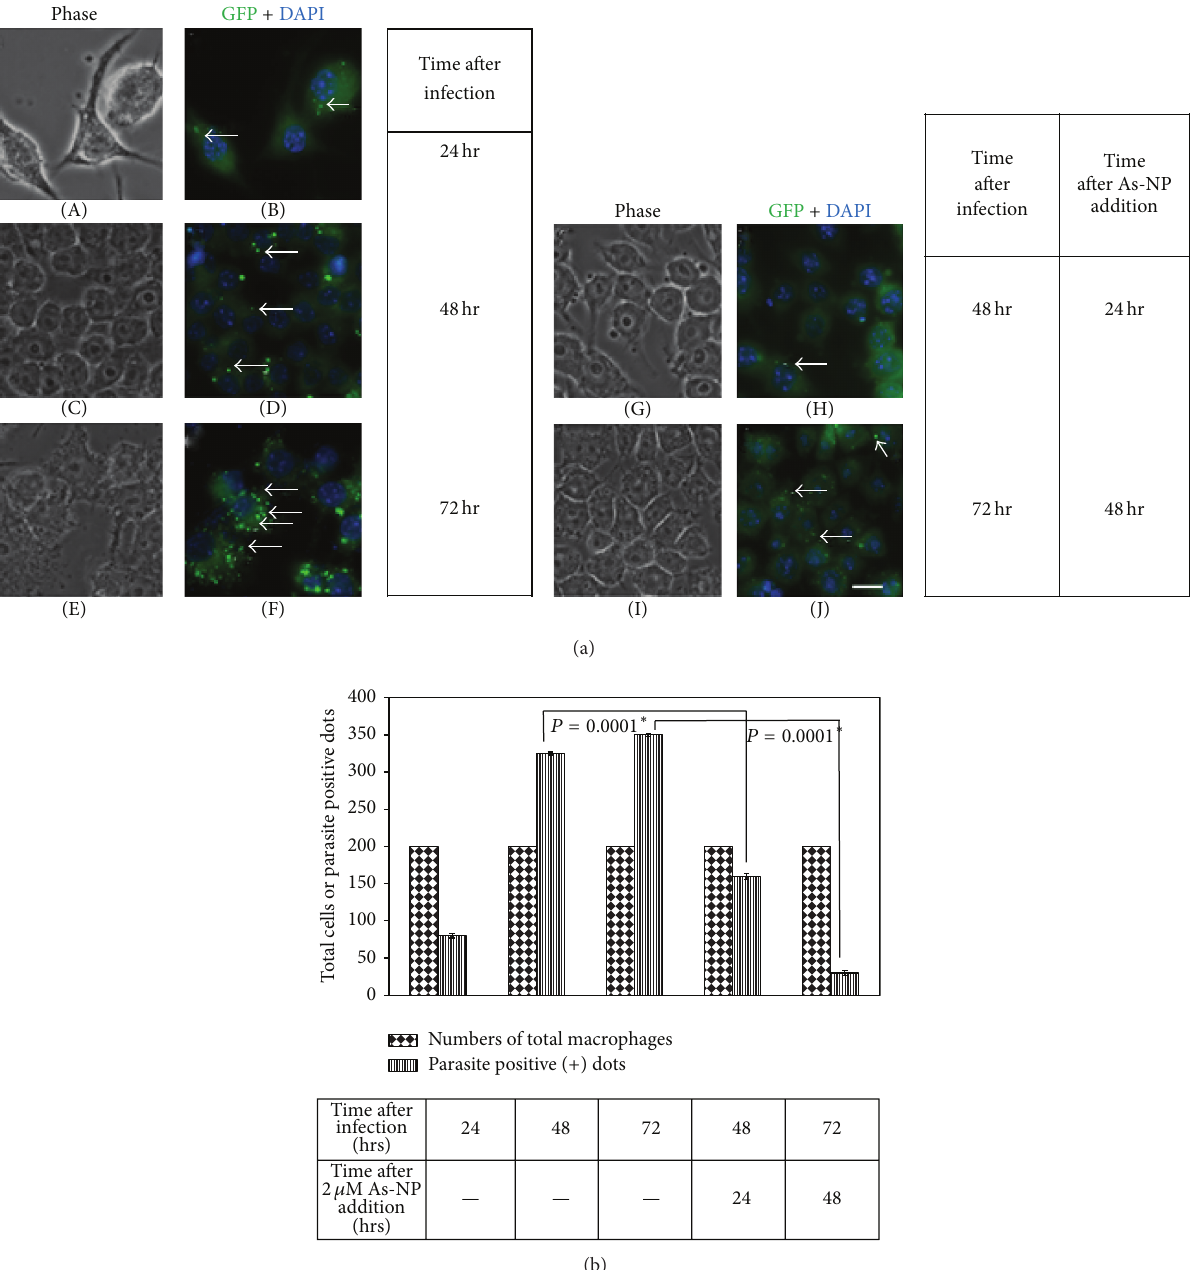
Figure 4: As-NPs blocked intramacrophage proliferation of Leishmania parasites. (a) As-NPs reduced the postinfection proliferation of the parasites inside the macrophages. RAW macrophages were infected with Leishmania promastigotes and incubated for 24 hours at 37 ∘ C. 24- hour postinfected macrophages (panels (A) and (B)) were further incubated without ((C)–(F)) and with ((G)–(J)) As - NPs for another 24 ((C), (D), (G), and (H)) and 48 ((E), (F), (I), and (J)) hours. Phase ((A), (C), (E), (G), and (I)), GFP (green), and DAPI (blue) pictures were taken in fluorescence microscope and the GFP and DAPI images were merged ((B), (D), (F), (H), and (J)). These images only represent one of multiple independent sets. Scale bar indicates 2 𝜇 m. (b) Quantitation of the intracellular proliferation of L. donovani promastigotes in 24-hour postinfected macrophages incubated in presence of 2 𝜇 M As - NPs for another 24 and 48 hours. Numbers of total macrophage and parasite positive (+) dots within each infected cell were separately determined by manual counting of representative images and presented graphically. The error bars indicate standard deviations for the number of parasite positive dots obtained from three independent experiments. ∗ denotes statistically significant 𝑃 values ( <